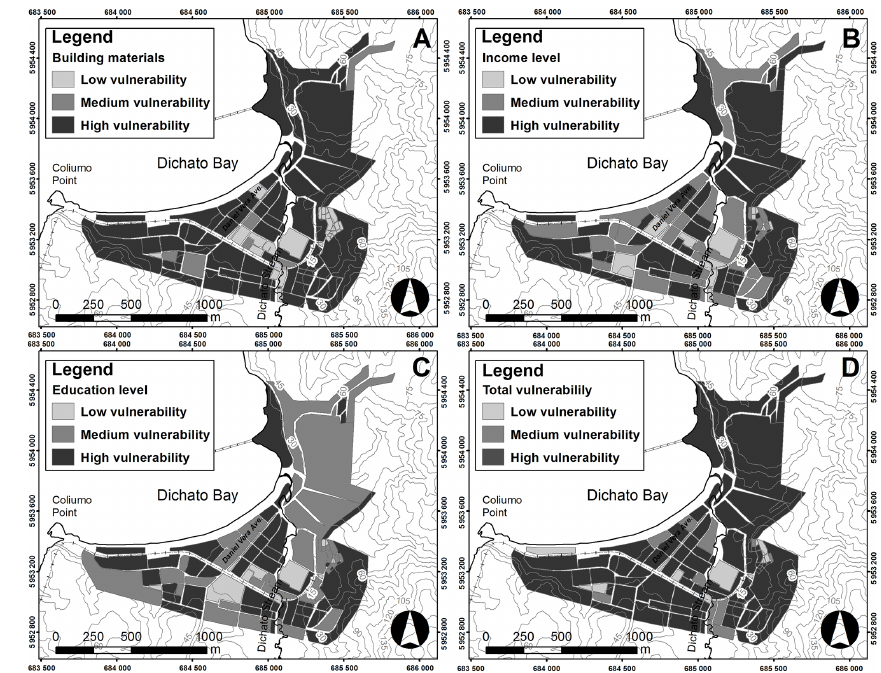
Figure 5. Pre-event tsunami vulnerability of the town of Dichato.